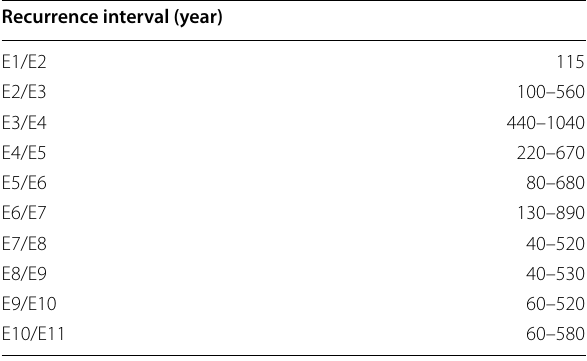
Table 4 Recurrence intervals based on the model